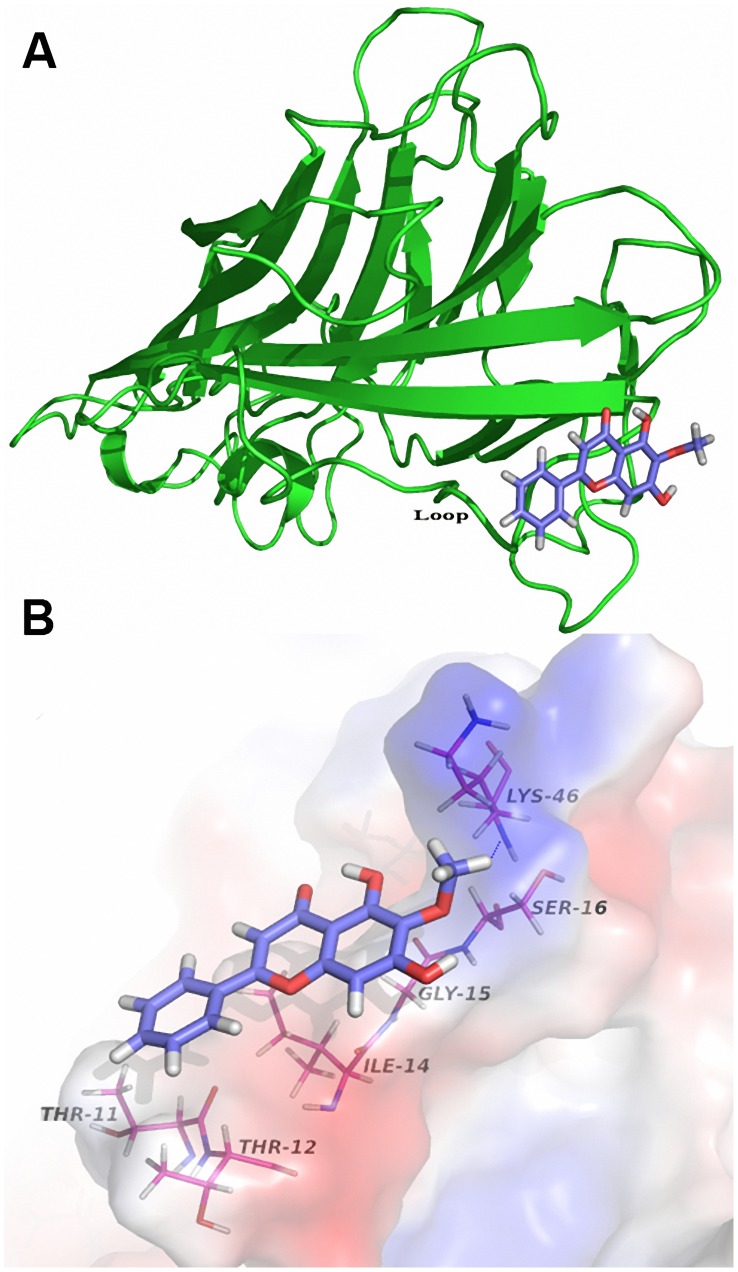
General view of the α-HL: ORO complex based on MD simulation.(A) MD simulation conformation of ORO in complex with α-HL. ORO is colored in pink. (B) Electrostatic potentials of the final binding site (blue = positive regions, red = negative regions, and white = neutral regions). Blue dotted lines indicate hydrogen bonds. The structure of the binding mode of ORO with α-HL shows the interaction of ORO with Thr11, Thr12, Ile14, Gly15 and Lys46.